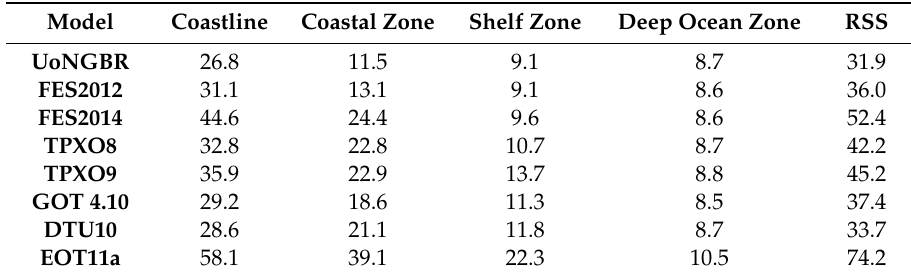
Table 7. The mean RMS of the SLAs in the challenging area over di ff erent zones (cm) with bold value indicating the minimum mean RMS. Model